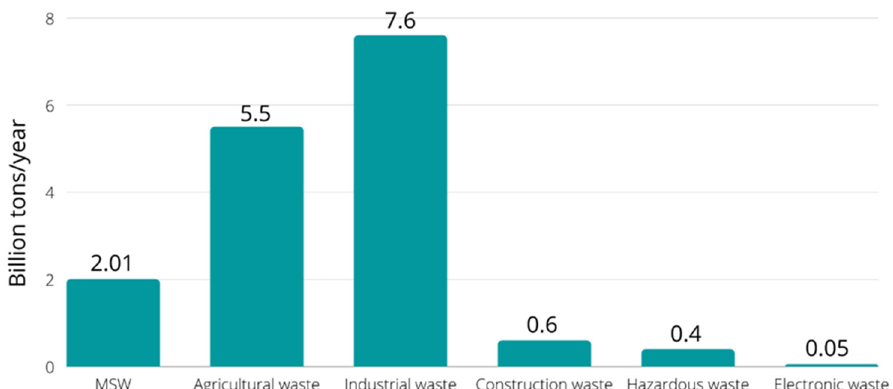
Figure 2. The global average of different steams waste generation [2,8–10].